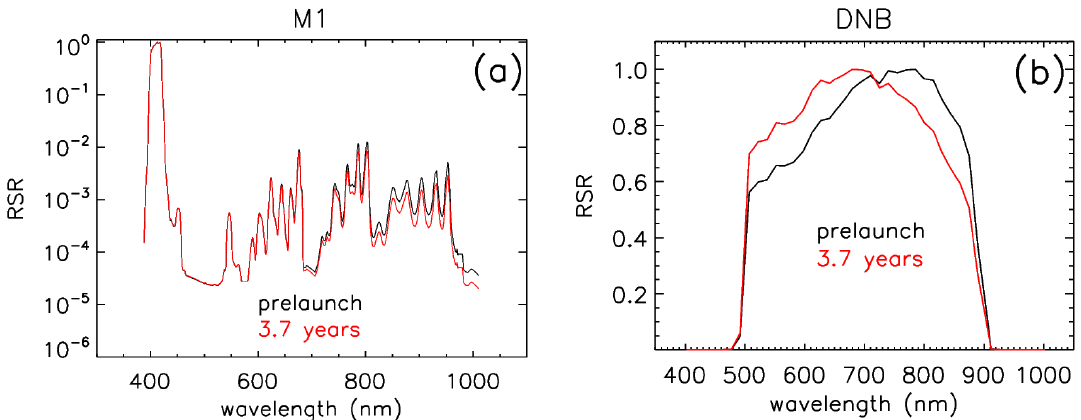
Figure 10. Comparison of the prelaunch RSR (black) and the modulated RSR at 3.7 years after launch (red) for band M1 ( a ) and the DNB ( b ).